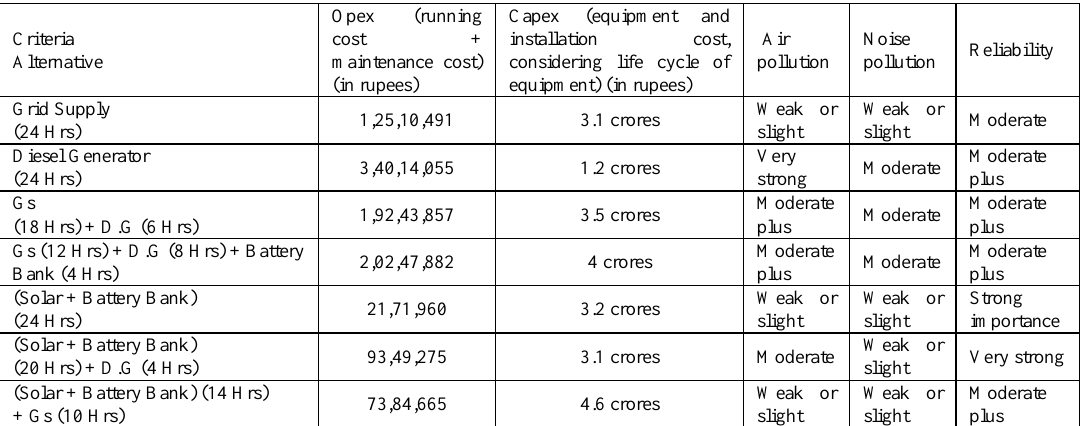
Table 4. Data of all the alternatives based on criteria